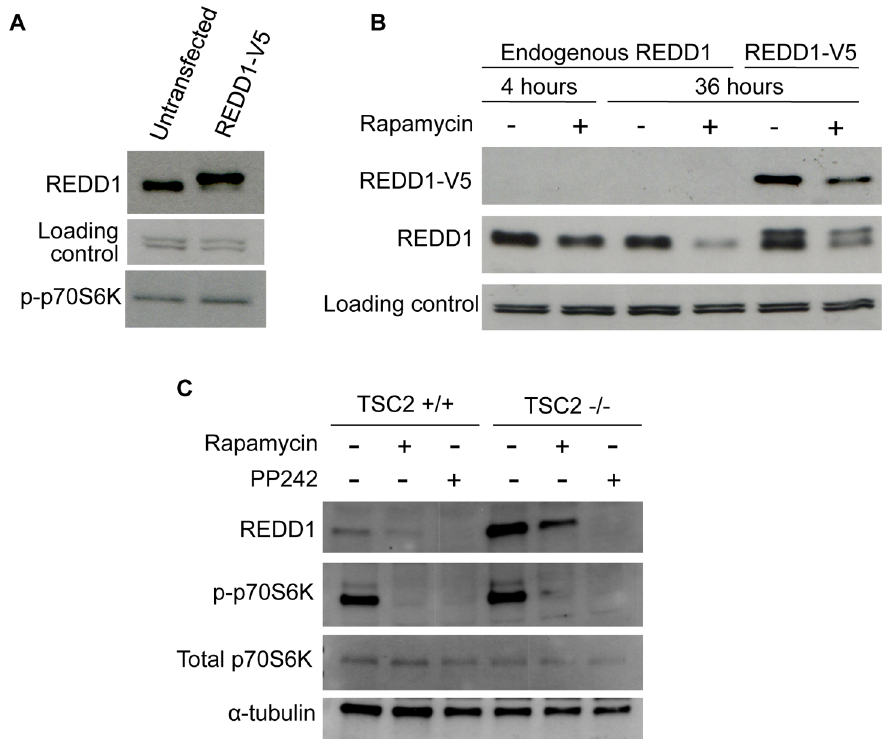
Figure 1. Negative feedback regulation of REDD1. ( A ) REDD1-V5 pcDNA3 (0.4 m g) was transfected in HEK293 cells for 3 days followed by cell lysis and detection of endogenous REDD1 proteins by Western blotting. ( B ) HEK293 cells with and without the transfection of REDD1-V5 pcDNA3 (0.15 m g) were treated with 20 nM rapamycin for 4 or 36 hours followed by cell lysis. ( C ) MEF TSC2 + / + and TSC2 2 / 2 cells were treated with rapamycin (40 nM) or PP242 (2 m M) for 24 hours before cell lysis. Detection of V5 tag, REDD1, a -tubulin, phosphorylated and total S6 Kinase 1 was performed by Western blotting as described in Materials and methods.